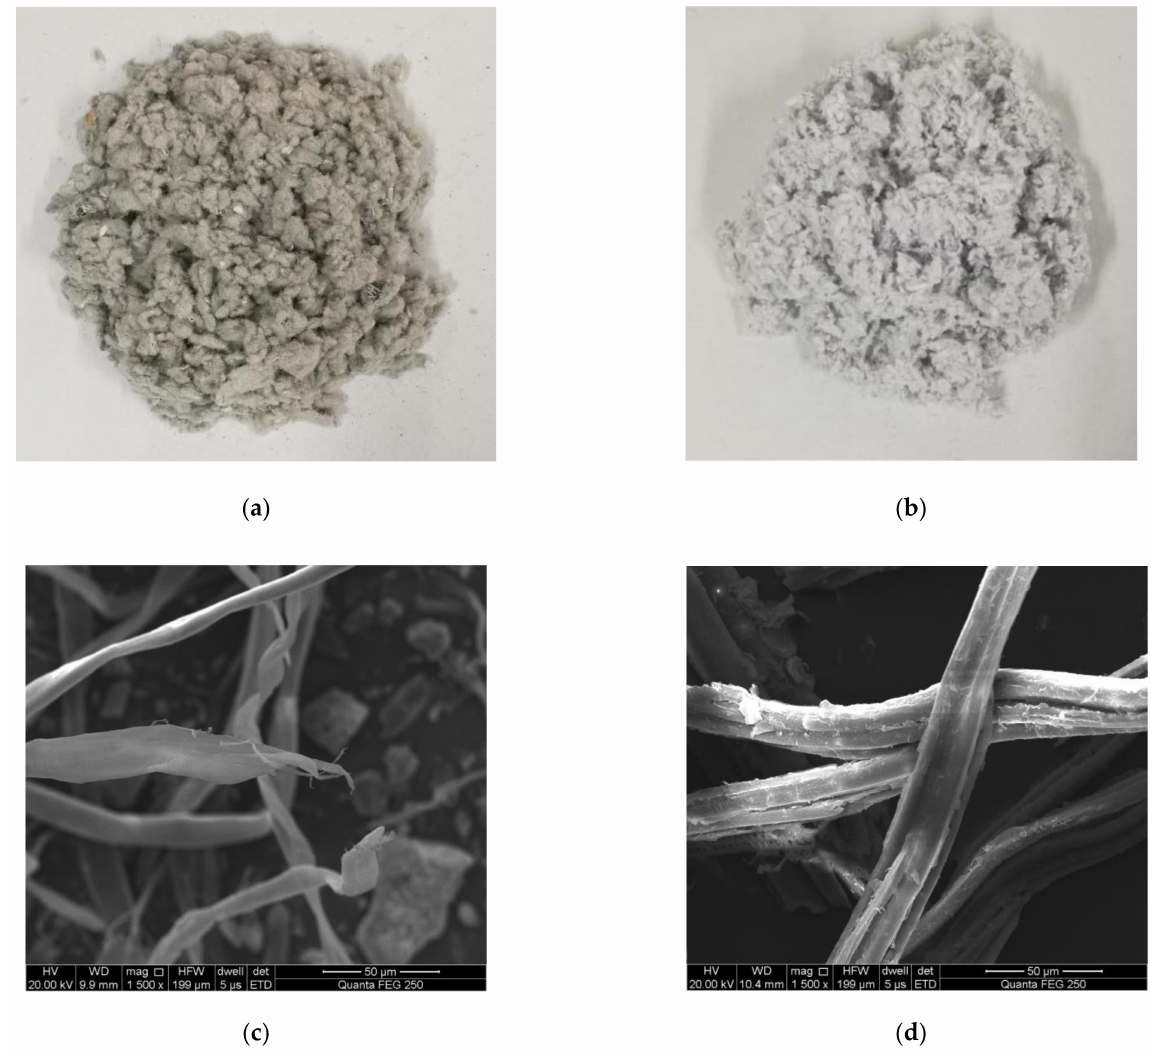
Figure 1. Digital photos of ( a ) lignin fiber and ( b ) bamboo fiber showing their difference in appearance vs. scanning electron microscope (SEM) micrographs of ( c ) lignin fiber and ( d ) bamboo fiber revealing their microstructures at the magnification of 1500 ×